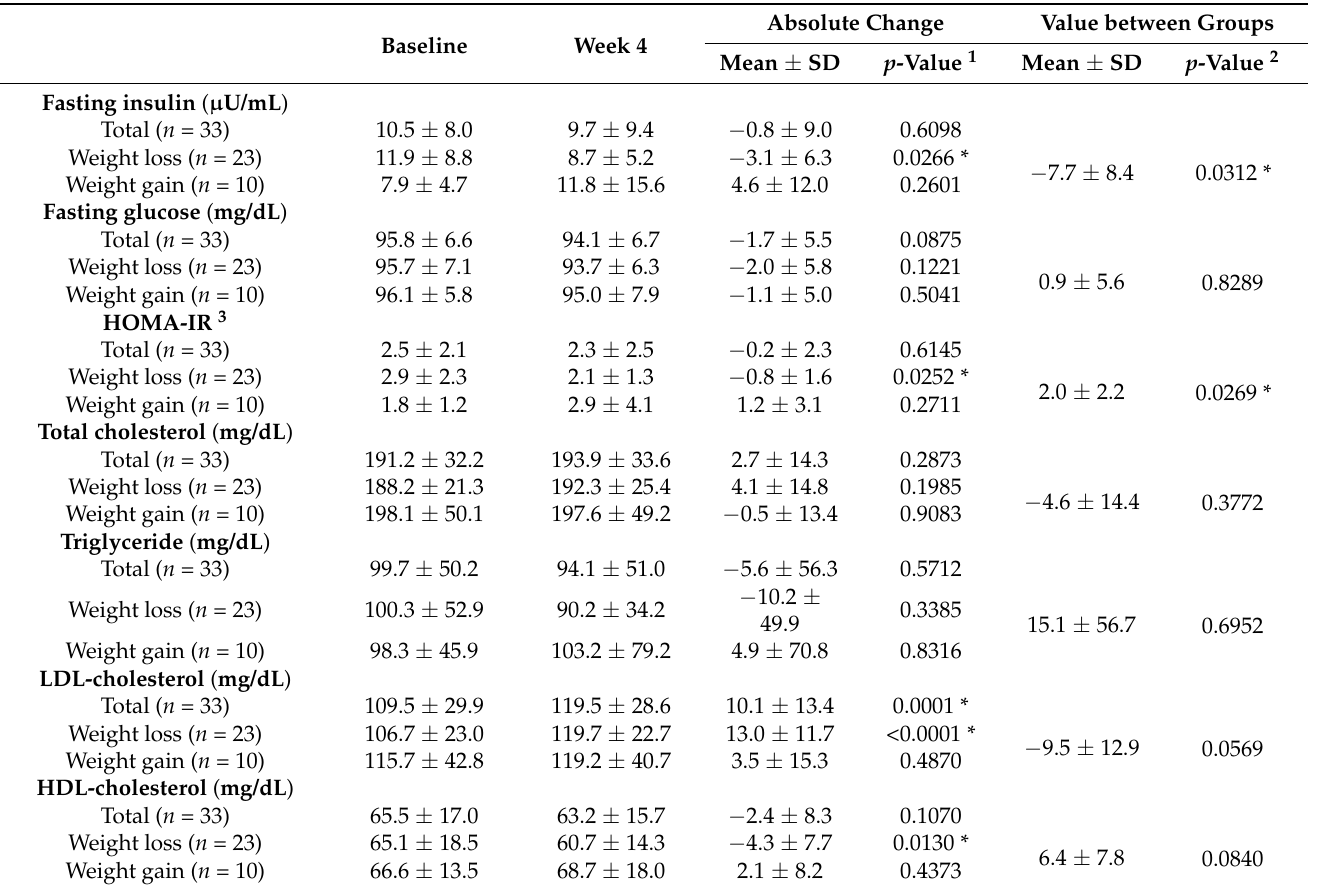
Table 3. Changes in biochemical parameters after 4 weeks of time-restricted